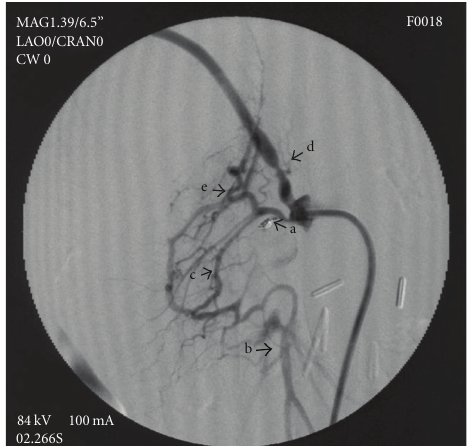
Figure 6: postembolisation angiogram showing complete exclusion of pseudoaneurysm without contrast filling. (a) coils within lumen, (b) postocclusive SMA, (c) patent inferior pancreaticoduodenal artery, (d) replaced right hepatic artery, and (e) branches of inferior pancreaticoduodenal artery.